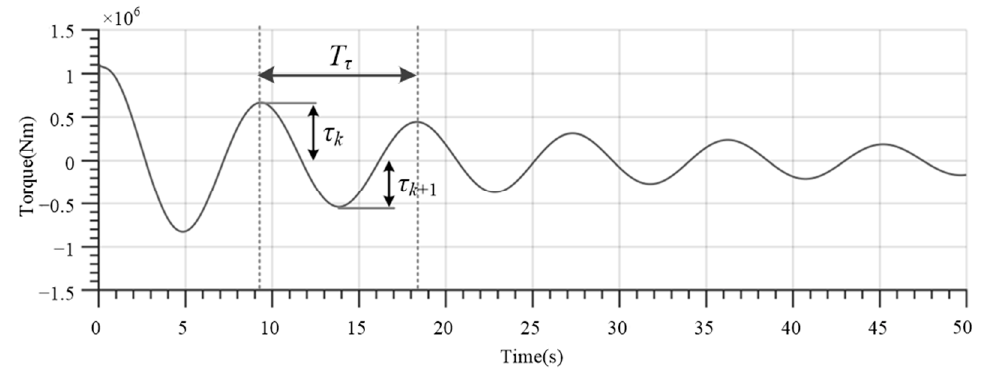
Figure 5. Cloud diagram of free oscillation of fl uid in the tank. The liquid level in the left tank is set to be 3.1 m, and the liquid level in the right tank is 1.5 m. The free decay curve of the fluid in the water tank is simulated, as shown in Figure 6. According to the free decay curve, the tank period T τ is about 8.975 s and the dimension- less damping coe ffi cient n t is 0.062.